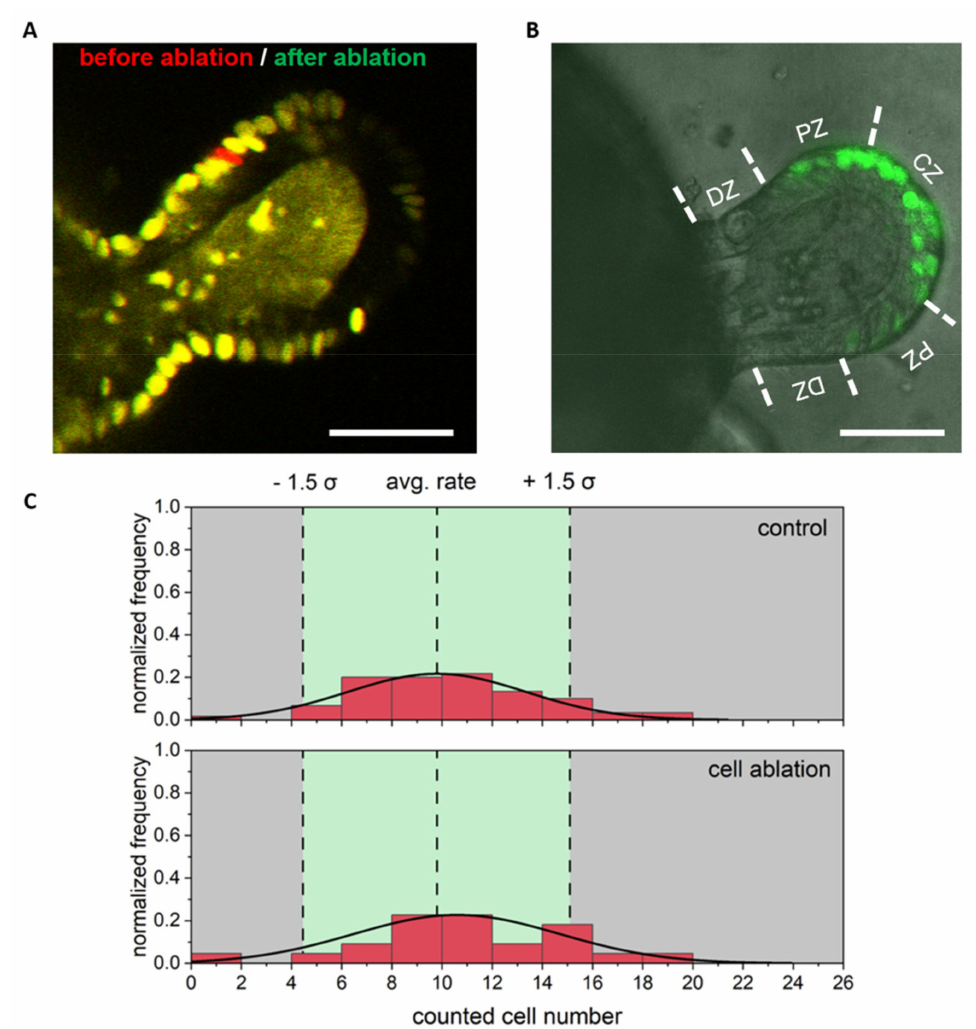
Figure 5. Regeneration and proliferation after ablation of a single cell in the proliferative area. ( A ) Overlay of an image before (red) and after (green) cell ablation. ( B ) Exemplary stack image from the same colonoid as shown in ( A ) after fixation and EdU staining, showing many EdU positive (green) cells in this area. The differentiated zone (DZ), proliferative zone (PZ), and crypt zone (CZ) were delineated from each other by dashed line. ( C ) Frequency of counted EdU positive cells: In the proliferative zone, proliferation (based on counted, positive EdU cells) in all samples and no statistical differences between control and ablation group were found. Scale bar 50 µ m and n ≥ 21 colonoids. The 3D dataset to ( B ) is provided as Supplementary Video